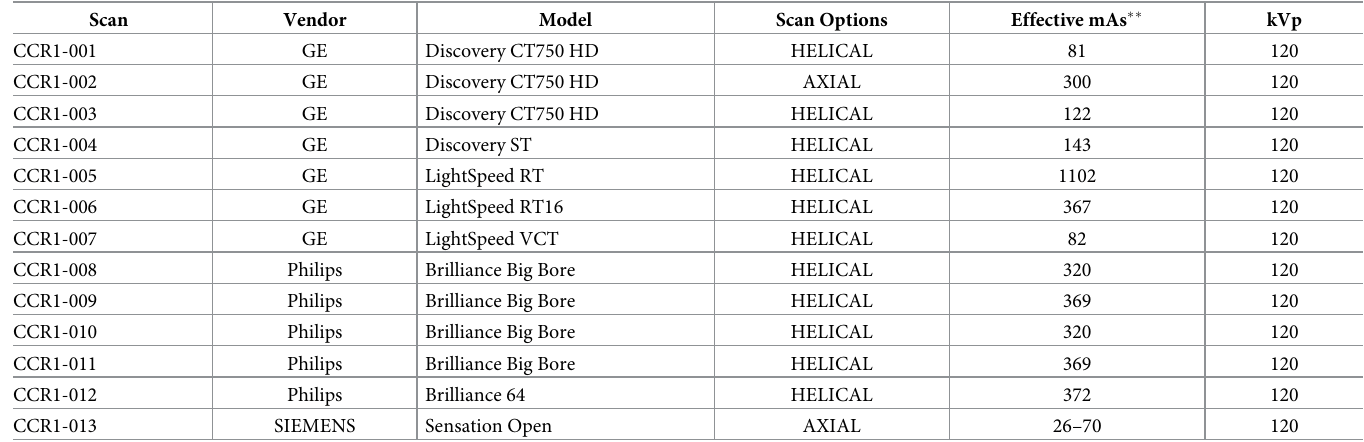
Table 1. CT acquisition parameters � .